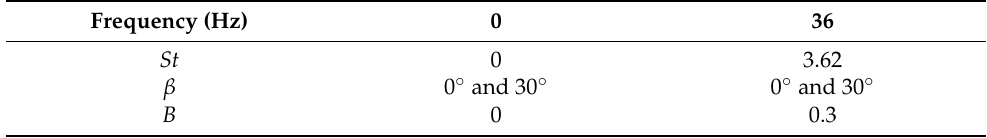
Table 3. B values in Equation (11) in terms of frequency and Strouhal number ( St